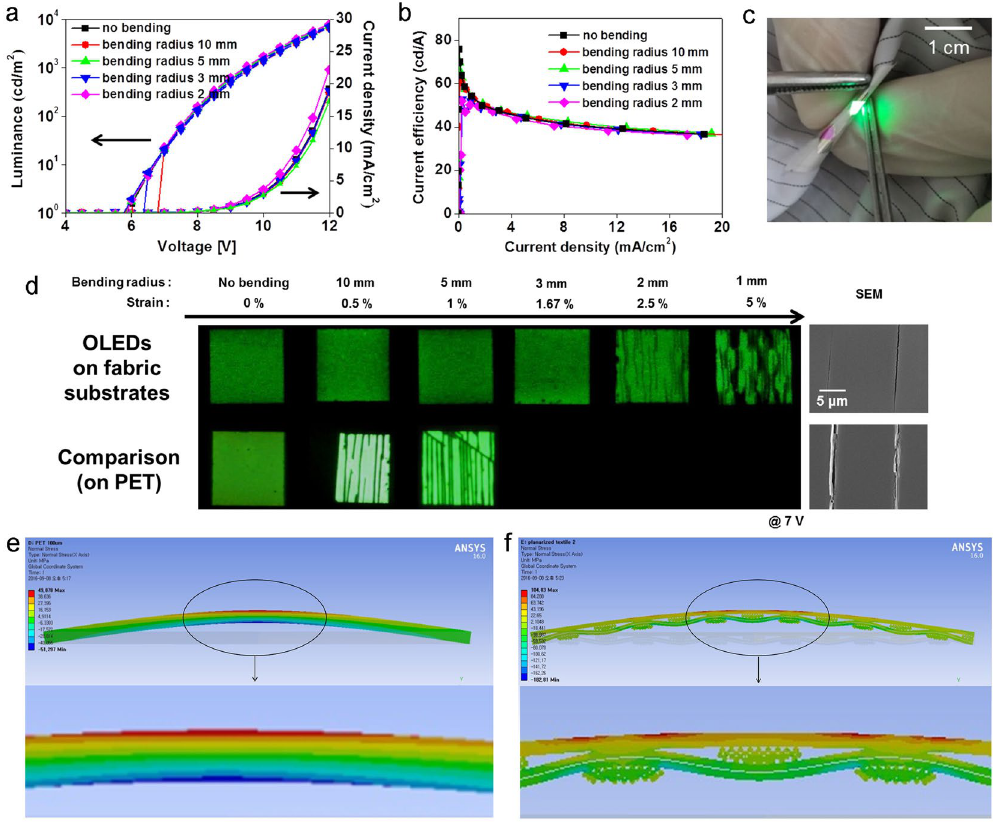
Figure 5. Bending strain: ( a,b ) Deviations of the electrical-optical performance capabilities according to the bending strain, ( a ) J-V-L characteristics, and ( b ) current efficiency. ( c ) Photograph of the emitting device under the bent condition. ( d ) Cell and SEM images of devices on the fabric and PET after the bending test. ( e,f ) Bending motion simulations using the finite element method (FEM), ( e ) two-dimensional film structure and enlarged image, and ( f ) two-dimensional planarized fabric structure and enlarged